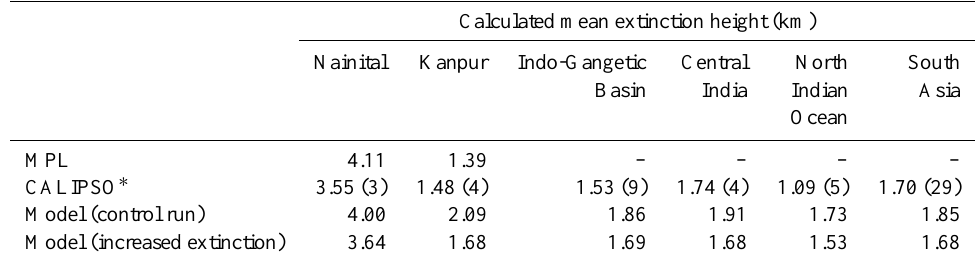
Table 2. Calculated mean extinction height (km) from observations (MPL and CALIPSO) and model simulations over different regions in March 2012.